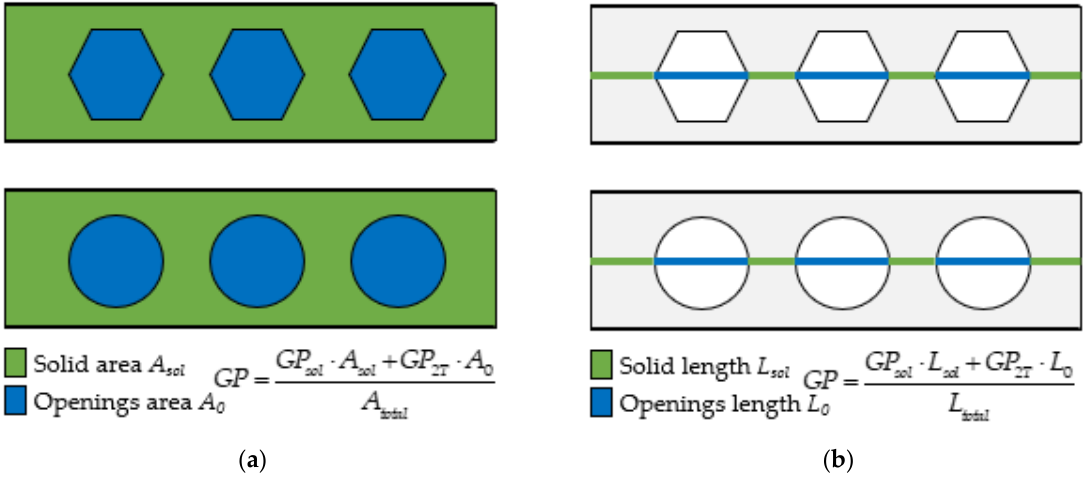
Figure 8. Approaches to weighting the geometric properties of the cross-section: ( a ) superficial way; ( b ) linear. Adapted from Carvalho, Rossi, and Martins